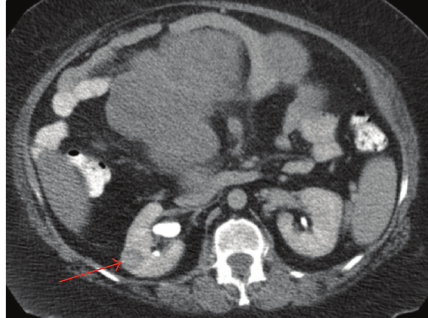
Figure 2: Abdomen CT scan with IV and PO contrast, axial view. Solid mas in the right kidney (red arrow).